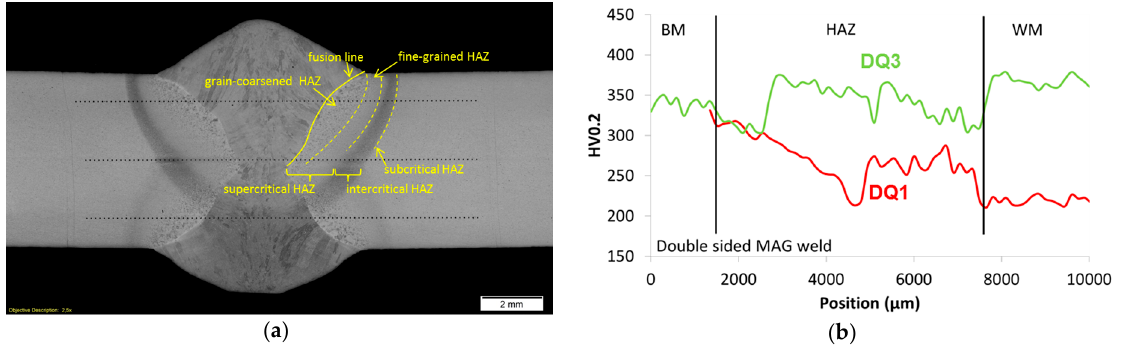
Figure 7. ( a ) Lab produced double-sided GMAW weld (Note: weld made with a specified heat input; not optimized for weld shape), ( b ) Hardness profile across the heat-affected zone (HAZ) of similar double-sided GMAW welds for the DQ1 and DQ3 steels. (Thickness: 6 mm, t 8/5 = 7 s).